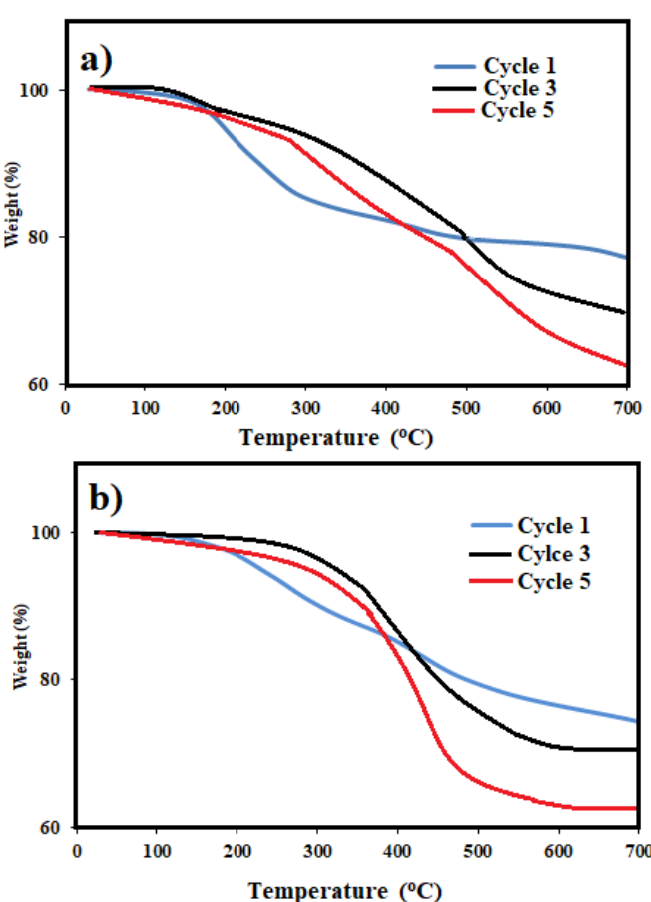
Figure 10. TGA thermograms of magnetite nanomaterials ( a ) coated by M. aurea extract (MAE-MNMs) and ( b ) by O. baccatus extract (OBE-MNMs) after different cycles.